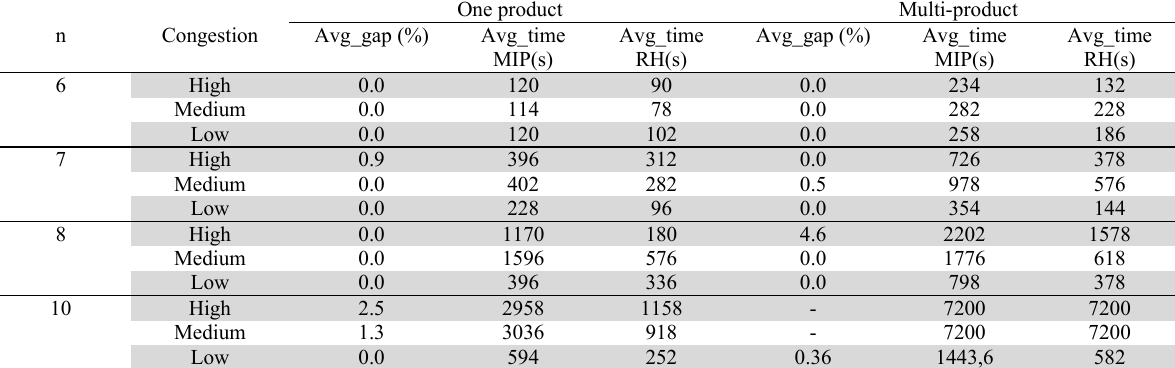
The results of the rolling horizon approach for small and medium instances One product